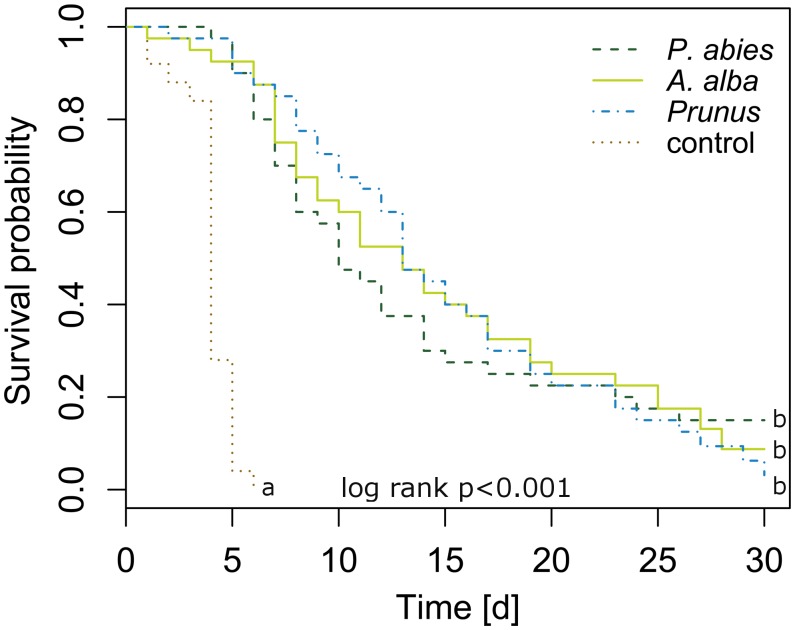
Kaplan–Meier curves visualizing the survival of newly emerged emigrants caged on P. abies (n = 40), A. alba (n = 40), P. domestica cv. Wavit (n = 40), or in cages without a plant (control, n = 25). Letters indicate significant differences between survival curves (likelihood ratio = 81.76, df = 3, R2 = 0.431, p < 0.001).